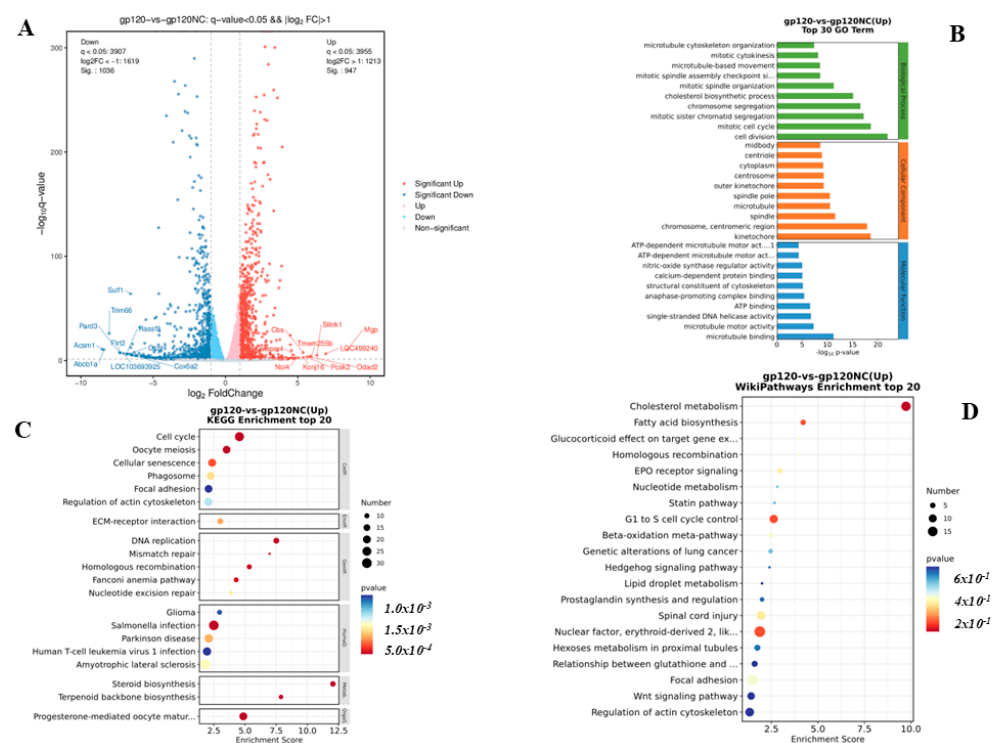
Figure 3. Volcano plot of DEG, GO functional analysis of DEG, KEGG pathway and wiki pathways enrichment analysis of transcriptomics PC12 cells samples overexpressing gp120. ( A ) Volcano plot of differentially expressed genes, genes with significant differences in expression are shown in red (upregulated) or dark blue (downregulated). Genes with differential expression but that could not reach the significant level are shown in light red (upregulated) or light green (downregulated). Genes with no significant differential expression are shown in grey. The vertical lines represent 2.0-fold up- and down-regulation. The horizontal lines indicate an adjusted p value of 0.05. (Q-value = adjusted p -value). ( B ) Top 30 GO terms were identified in the Transcriptomics and were displayed in the biological process (green), cellular component (orange), and molecular function sections (light blue). The adjusted statistically significant values for all of the variables were negative 10-base log transformed. DEGs are abbreviation for differentially expressed genes, while GO is abbreviation for gene ontology. ( C ) The top 20 KEGG enriched gene pathway-related disorders were examined using a KEGG pathway analysis. Low q-values are highlighted in red, while high q-values are highlighted in blue; the size of the circle is proportional to the number of enriched genes. (KEGG), stands for Kyoto Encyclopedia of Genes and Genomes, (DEG) stands for Differential Expressed Genes. ( D ) Wiki Pathways enrichment analysis top 20 ( p < 0.05).